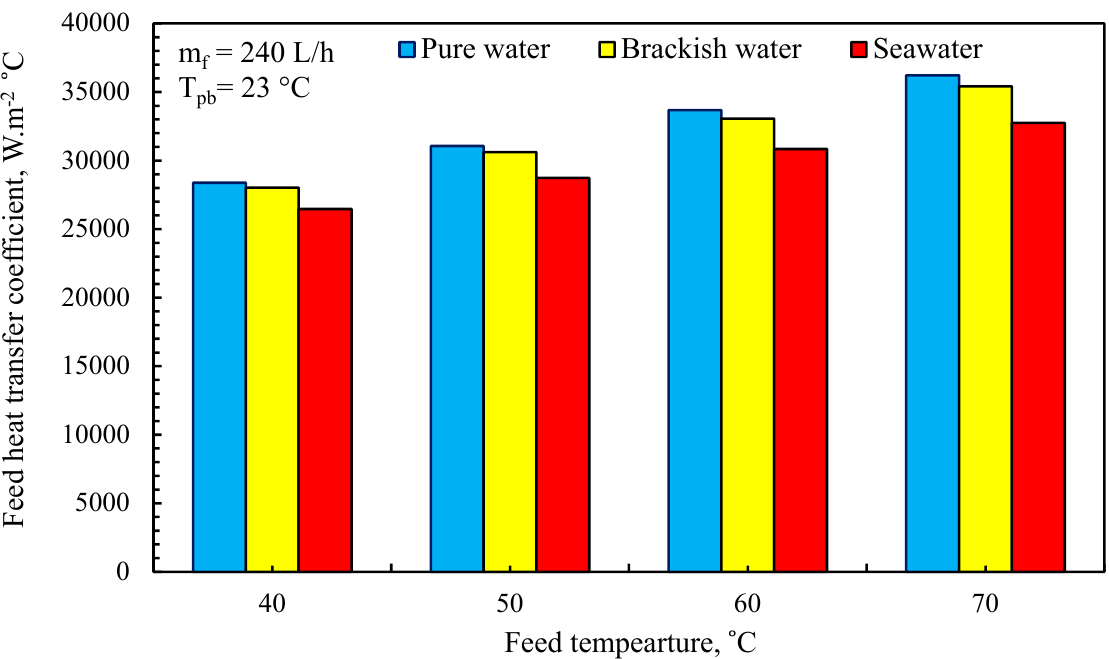
Figure 10. Effect of feed temperature on heat transfer coefficient ( m f = 240 L/min, T pb = 23 °C).